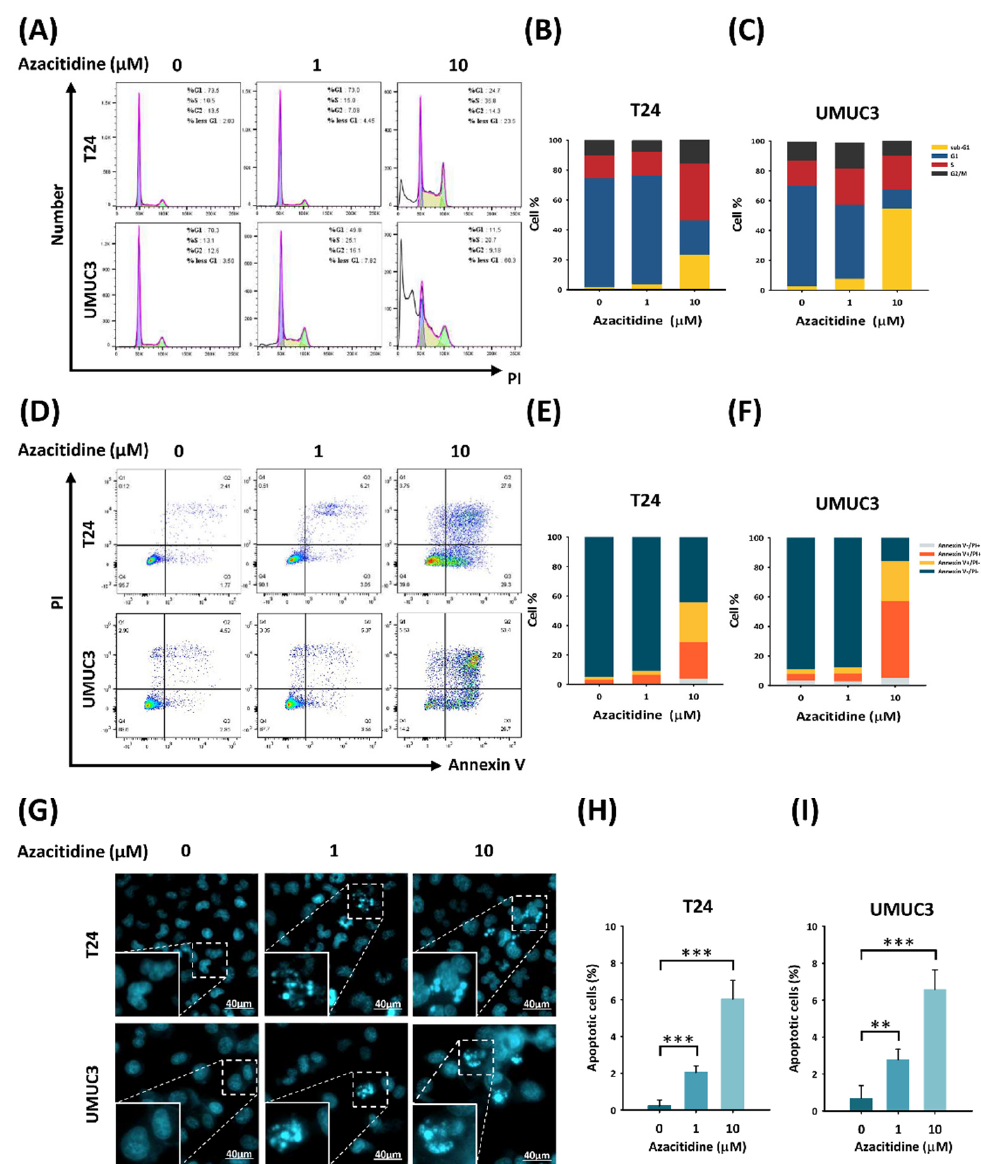
Figure 2. Azacitidine promotes apoptosis of UBUC cell lines. ( A ) Azacitidine increased the accumulation of UBUC cells in the sub-G1 phase. Cell cycle distributions, analyzed by flow cytometry, are shown for T24 ( B ) and UMUC3 ( C ) cells. ( D ) Azacitidine drove UBUC cell populations to early and late apoptosis, as determined by flow cytometry following dual staining with annexin V and PI. The proportions of annexin V +/ − and PI +/ − T24 ( E ) and UMUC3 ( F ) cells are shown. ( G ) The numbers of apoptotic UBUC cells increased in response to azacitidine treatment. Cell morphology changes caused by azacitidine were investigated by Hoechst 33,342 staining and viewing at 20 × magnification. ( H , I ) Columns represent apoptotic cell percentages for T24 and UMUC3 cells. Data are shown as mean ± s.d. (* p < 0.05; ** p < 0.01; *** p < 0.001).